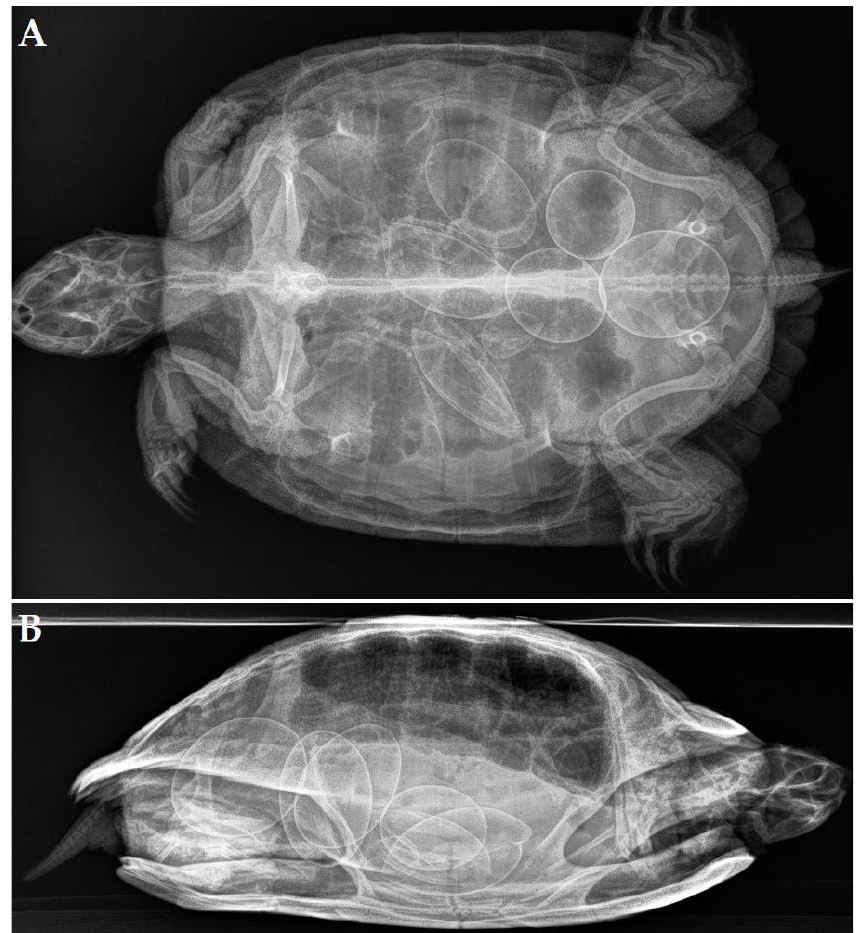
Figure 5. Ventrodorsal ( A ) and laterolateral ( B ) radiograph of a red-eared slider ( Trachemys scripta elegans ) with obstructive dystocia revealing the presence of 7 eggs with a well-mineralized shell. The 2 most cranial eggs with a normal size as well as an excessively small egg are collapsed, and the most caudal egg has a relatively large size and obstructs the pelvis